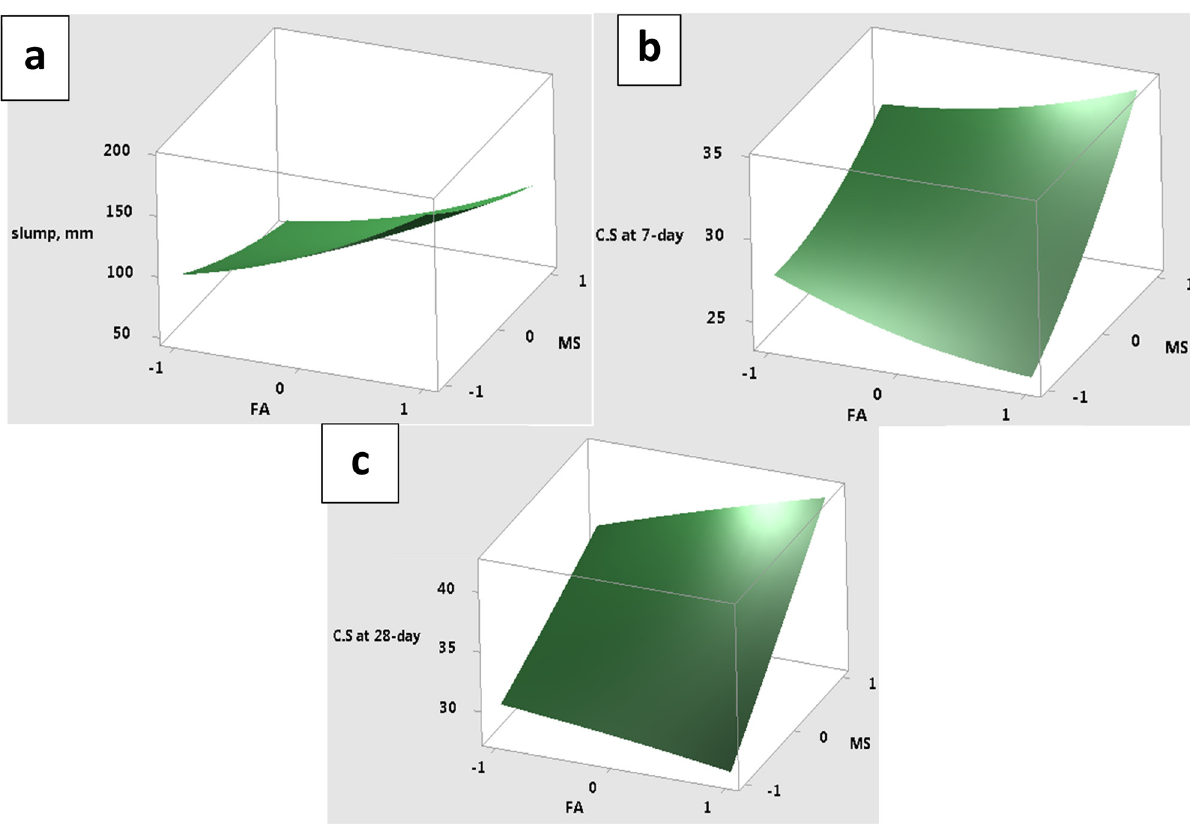
Figure 7: Surface Plot of ( a ) slump, mm, vs MS and FA ( b ) CS, MPa, at 7 days vs MS and FA ( c ) CS, MPa, at 28 days vs MS and FA.